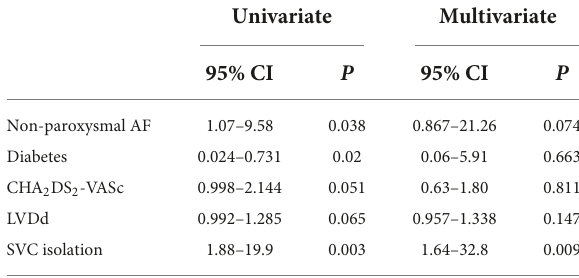
TABLE 5 P Univariate and multivariate analyses for factors predicting recurrence post the re-ablation procedure.